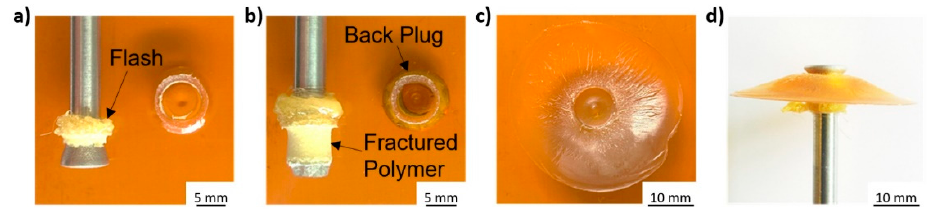
Figure 8. Examples of failure modes observed: ( a ) Condition 7 (RS = 18,000 rpm; FT = 2 s; FoT = 2 s; FF = 2000 N; FoF = 5100 N), full rivet pullout failure; ( b ) Condition 30 (RS = 19,000 rpm; FT = 2.2 s; FoT = 1.5 s; FF = 2500 N; FoF = 4500 N), rivet pullout with back plug; ( c ) Condition 13 (RS = 18,000 rpm; FT = 1.6 s; FoT = 2 s; FF = 3000 N; FoF = 5100 N), polymeric plate, rivet pullout failure; ( d ) Condition 13,